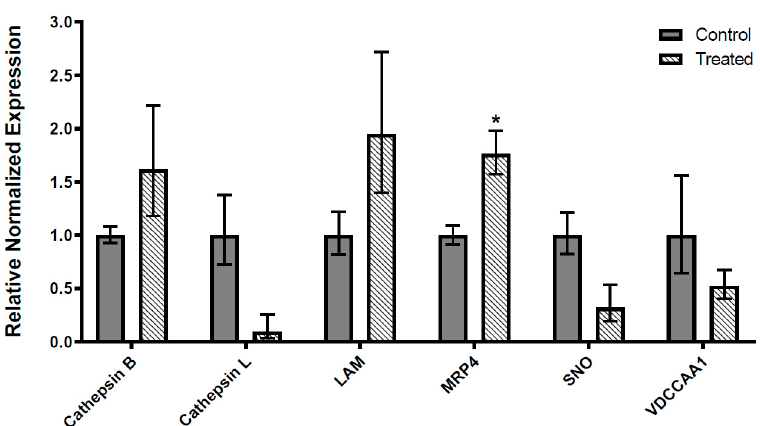
Figure 2. Expression of transcript levels in spinosad-treated versus control insects. Data presented